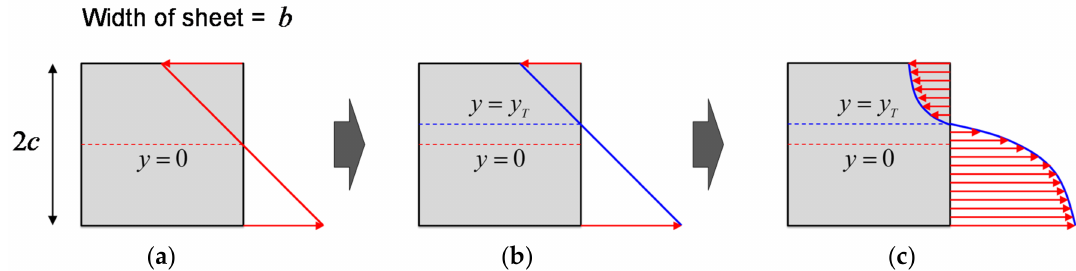
Figure 11. ( a ) the strain distribution on a sheet cross-section due to pure bending; ( b ) the strain distribution on the sheet cross-section upon the addition of a uniform tensile strain due to sheet stretching; and ( c ) the stress distribution on the sheet cross-section caused by the distribution of strain shown in ( b